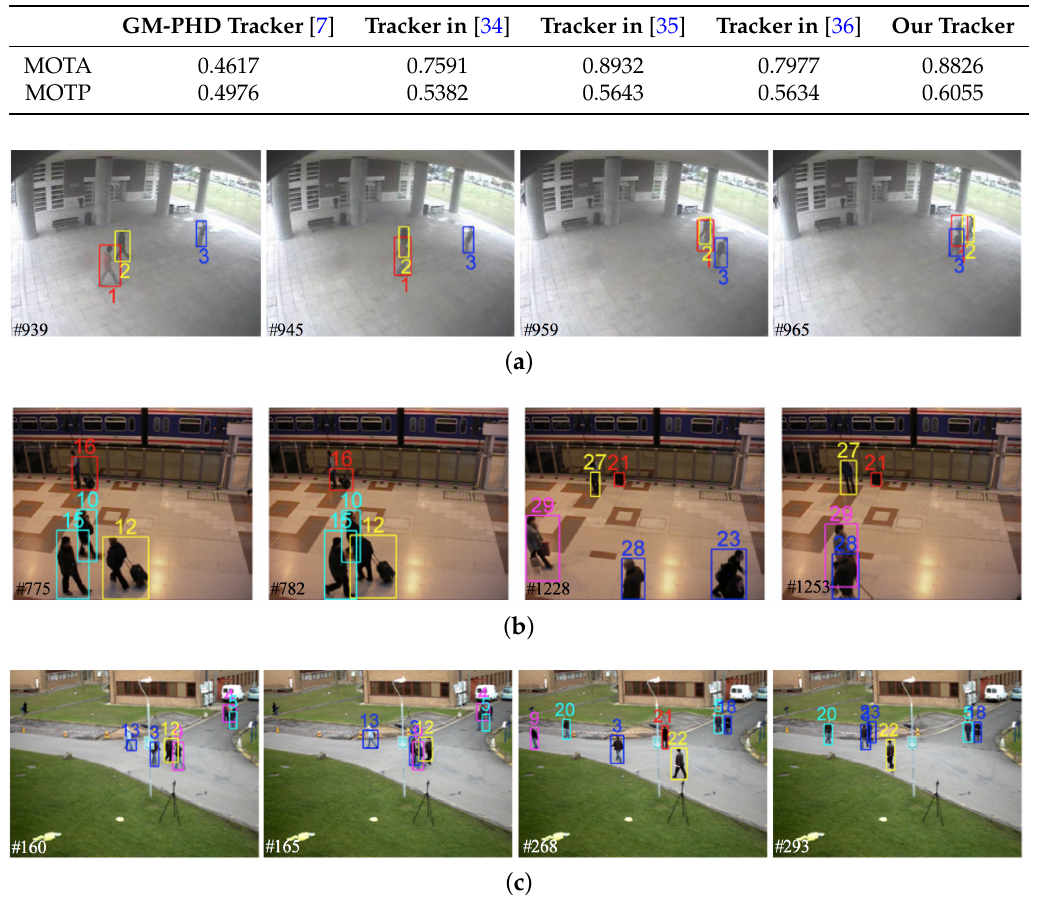
Figure 12. Tracking results of our tracker on three challenging surveillance scenarios. ( a ) Tracking interactive persons for public surveillance; ( b ) tracking persons and luggage for subway station surveillance; ( c ) tracking crowd persons for campus